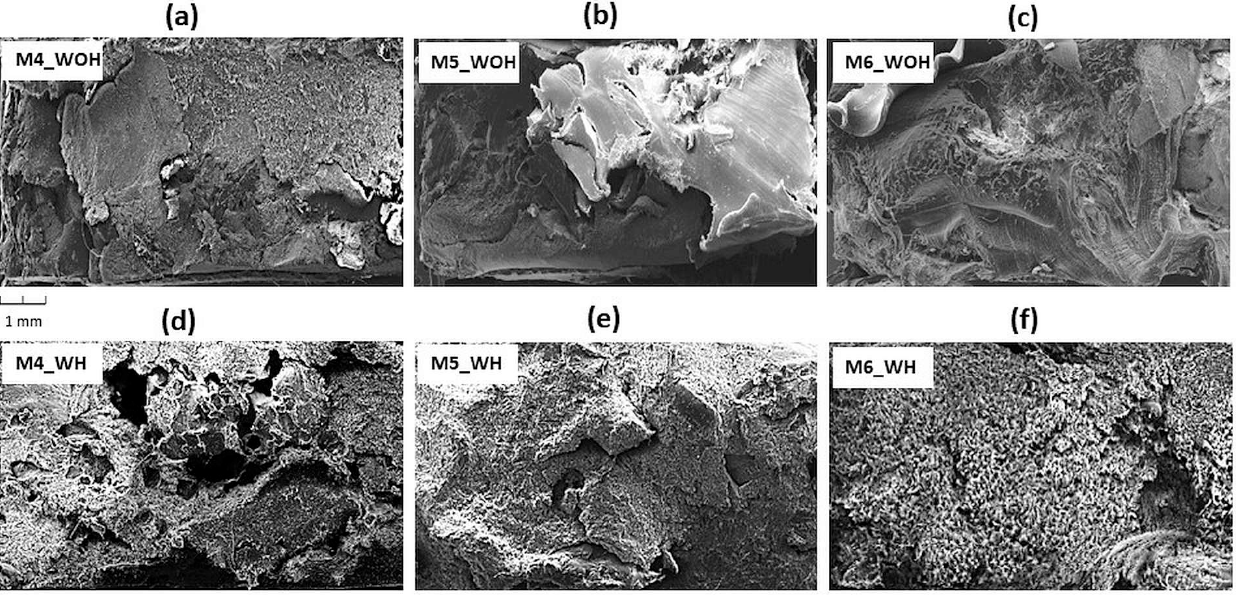
Figure 8. SEM images of the fractured surface ASR composites modified by different rLDPE content ( a – c ) without (WOH) and with ( d – f ) homogenization (WH).